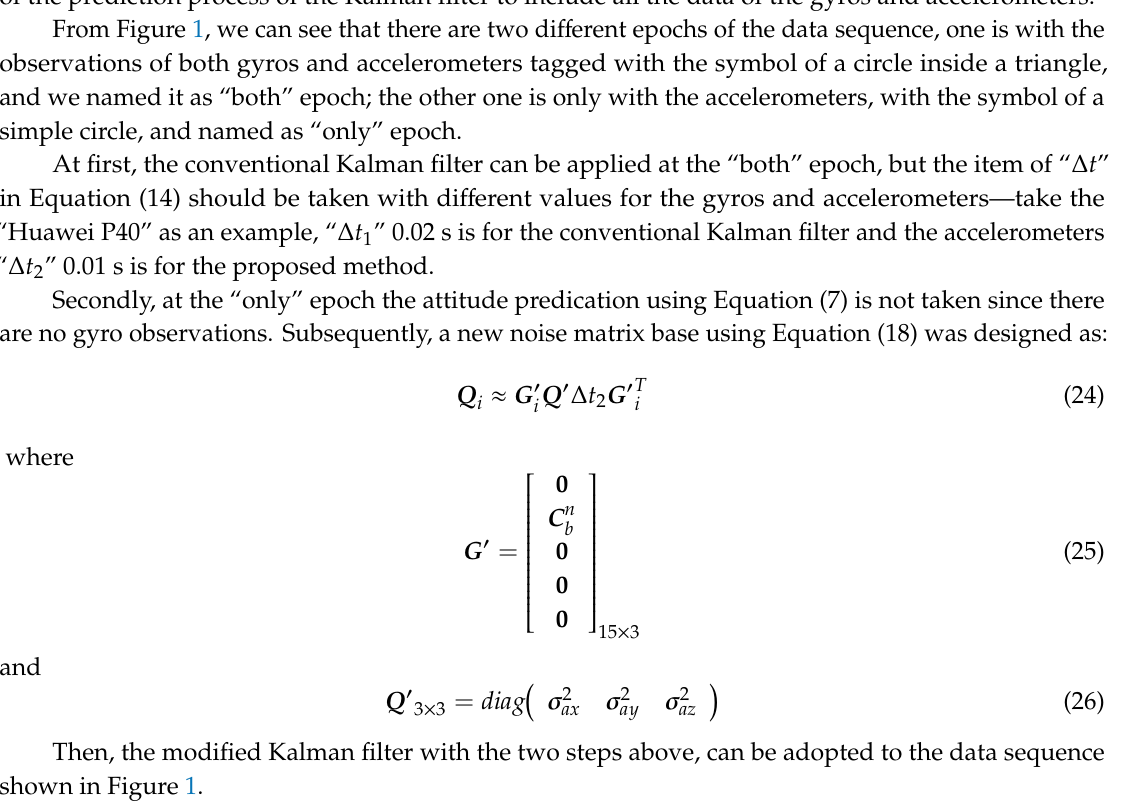
Figure 1. The sequence of the inertial measurement unit (IMU) data of the “Huawei P40”.